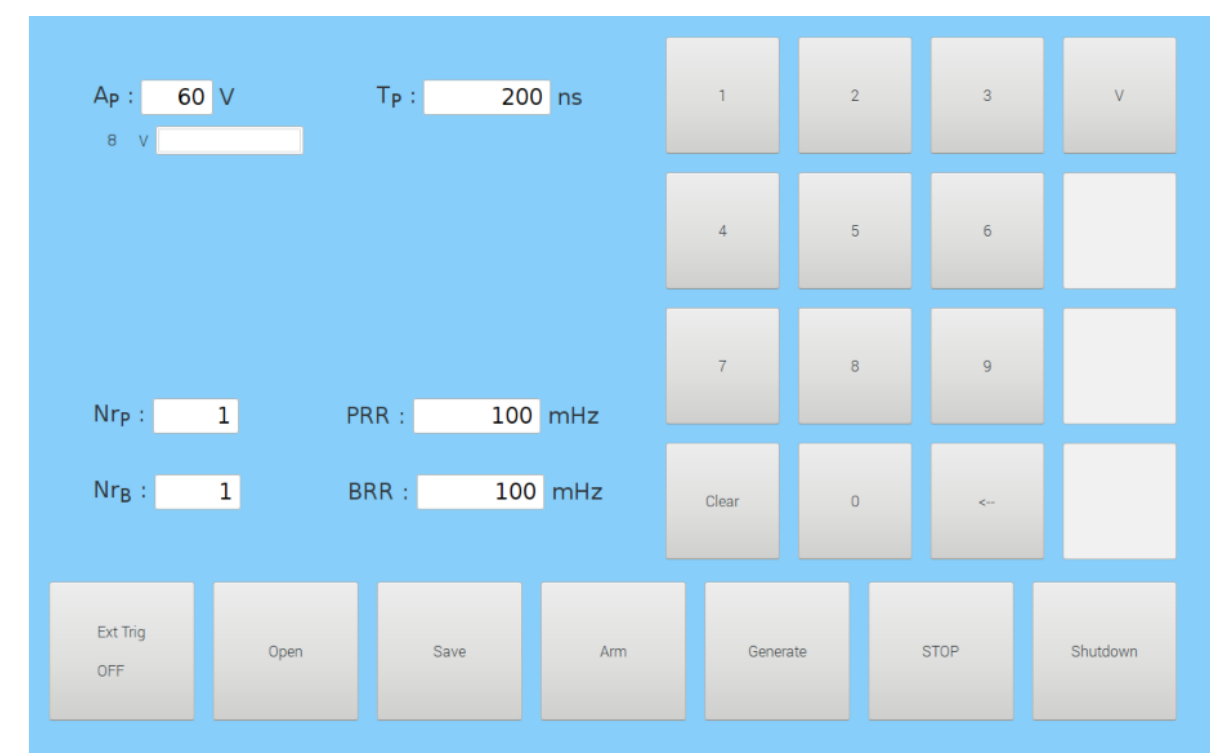
Figure 3. Graphical User Interface (GUI) of the device, displayed on the SunFounder 10.1 ″ touchscreen. The values of the parameters can be entered using the keyboard on the right side. A P — amplitude of the pulse; T P — duration of one pulse; Nr P — total number of pulses, Nr B — total number of bursts; PRR — Pulse Repetition Rate; BRR — Burst Repetition Rate.